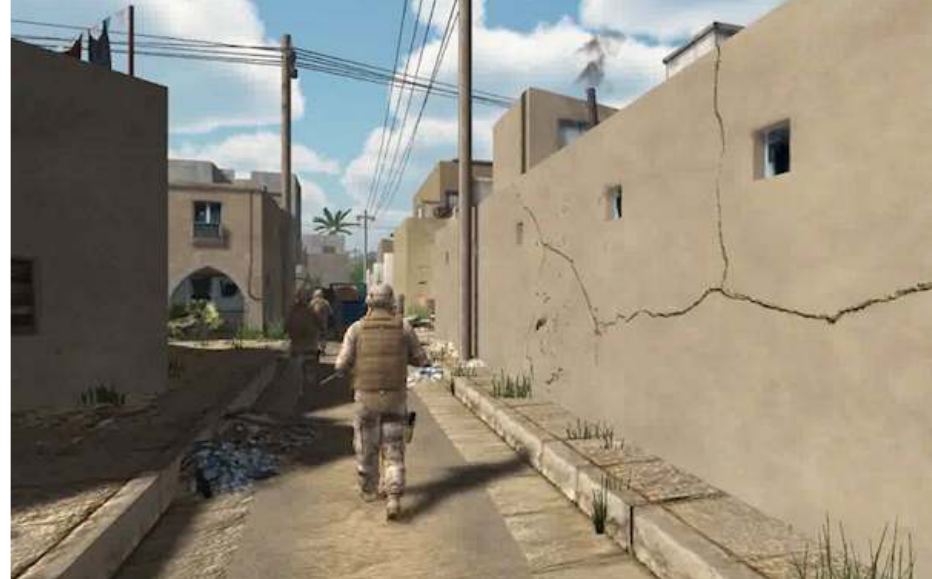
Figure 2: Example of a virtual scenario in